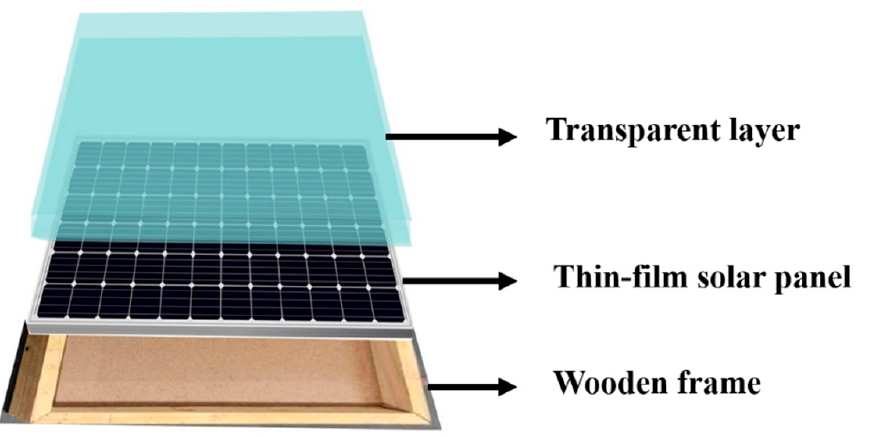
Figure 1. Schematic drawing for the solar module assembly. The middle layer consists of a flexible thin-film solar cell commercially known as PT15-300, having the dimensions of 270 mm × 325 mm × 1.12 mm. The properties of this solar cell are provided in Table